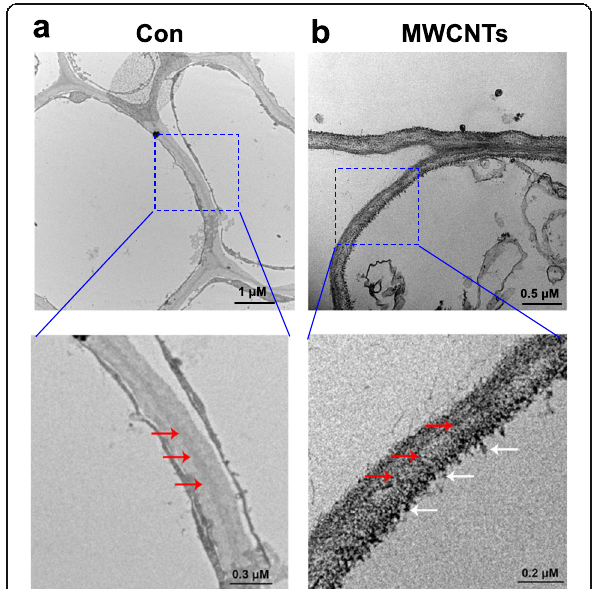
Fig. 3 Distribution of MWCNTs in tomato roots. TEM images of 3- day-old tomato seedlings treated with distilled water (Con; a ) or 5 mg/mL MWCNTs ( b ) for 1 day were taken. Red arrow indicates cell wall, while white arrow indicates MWCNTs